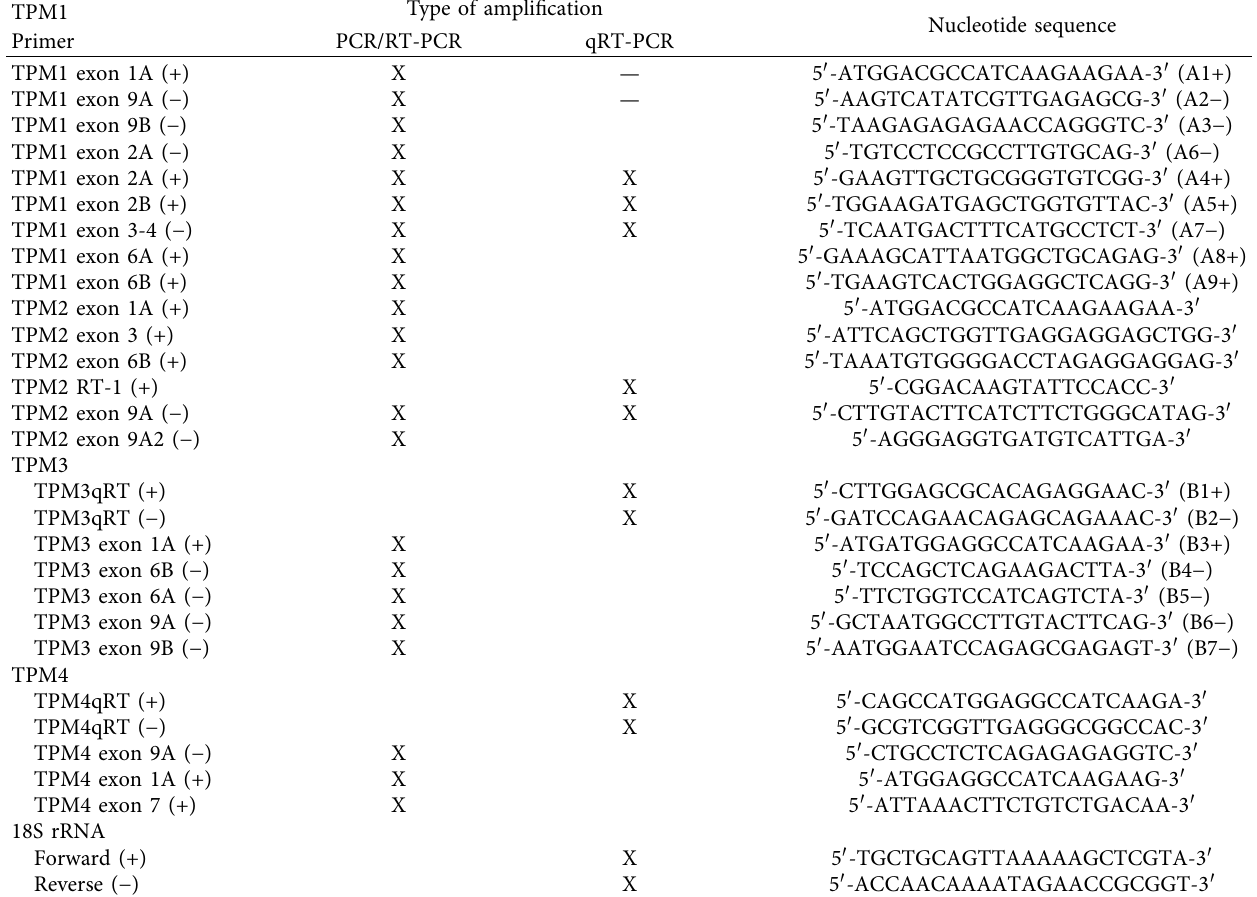
Table 1: Nucleotide sequences of the oligonucleotides used for primers and/or probes.